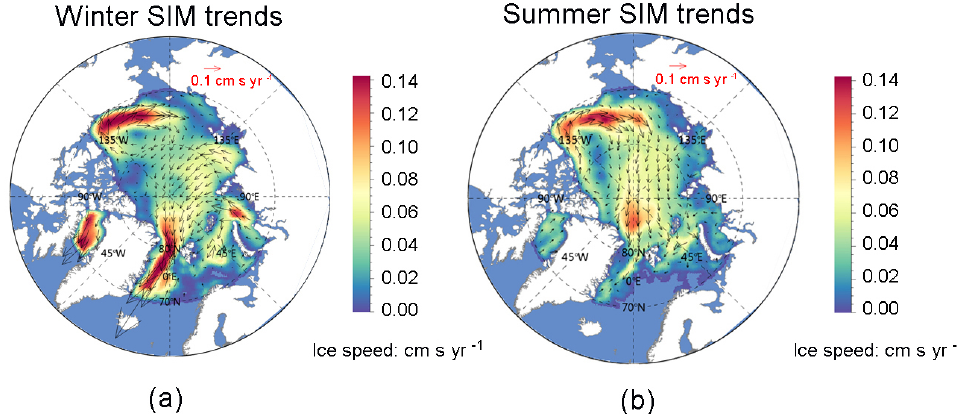
Figure 7. SIM trends during (a) winter (October–May) and (b) summer (June–September) over the period 1978/1979–2015/2016 and 1979– 2016, respectively.